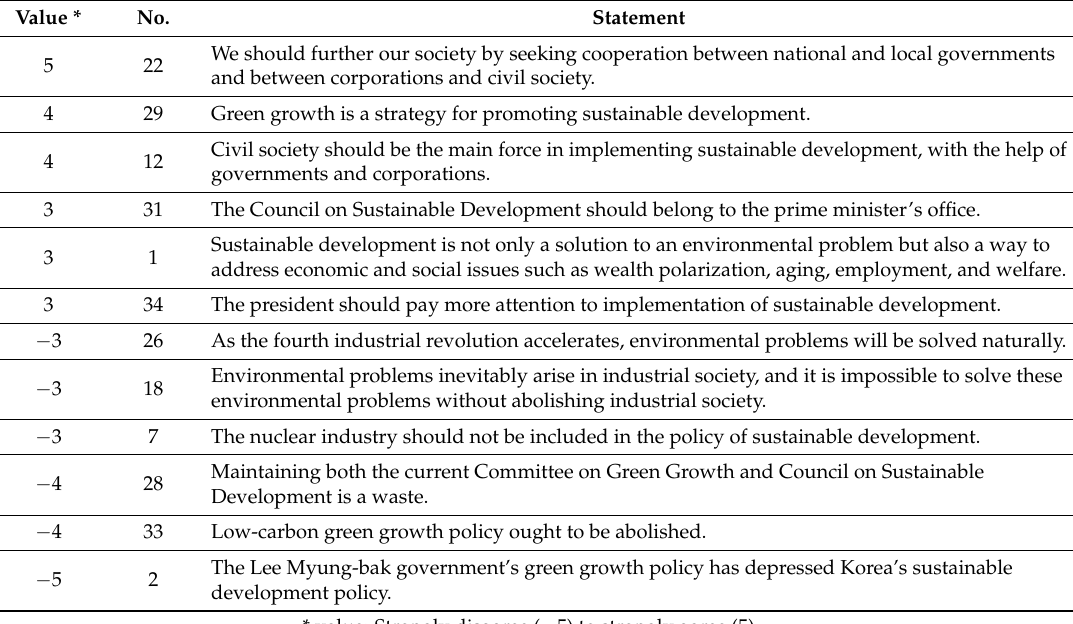
Table 8. Green Growth Advocates’ Q Statements.